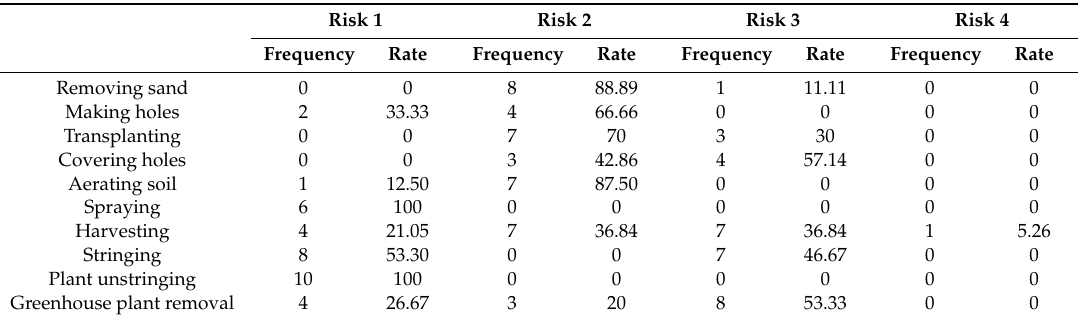
Table 5. Risks in each